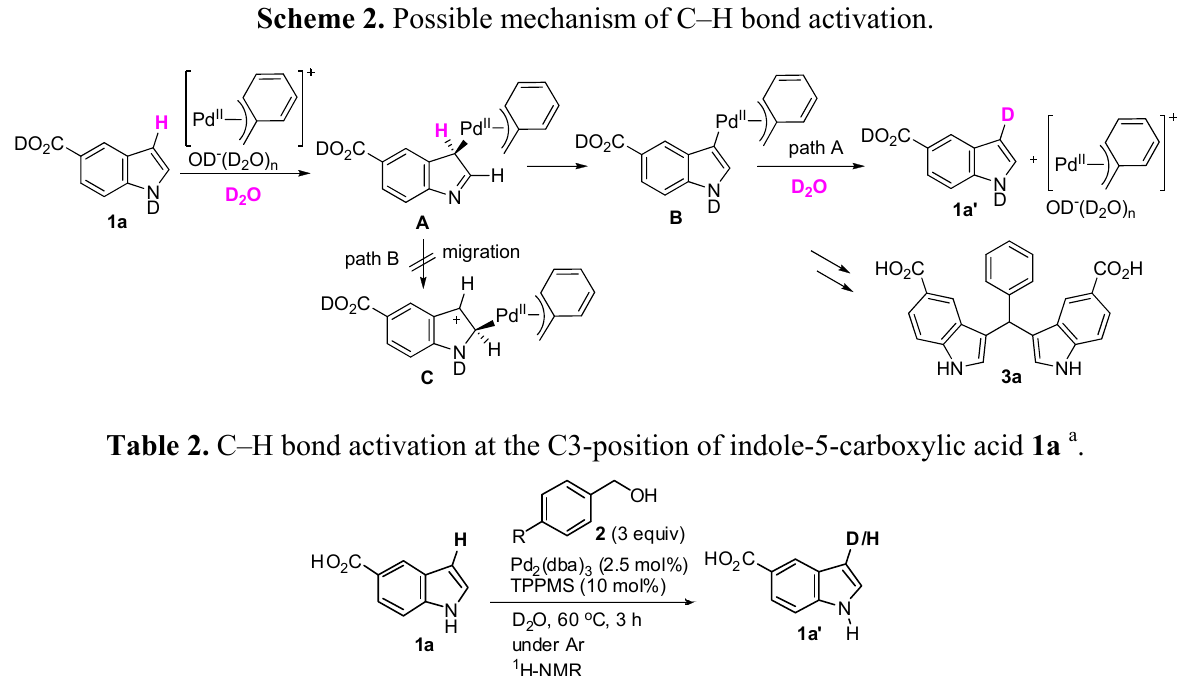
Scheme 2. Possible mechanism of C–H bond activation.